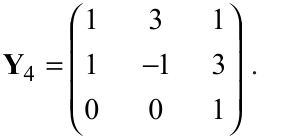
Figure 1 Affine magnification by Y (a) Vector x is reduced to a null vector. (b) The same happens to all points of the object resulting in the image being a point at the origin.